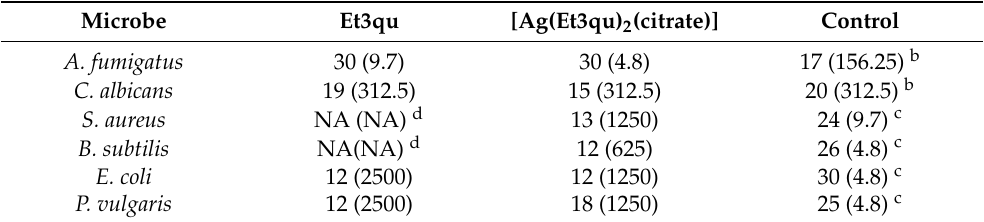
Table 5. Inhibition zone diameters (mm) and MIC ( µ g/mL) values for Et3qu and its [Ag(Et3qu) 2 (citrate)] complex a